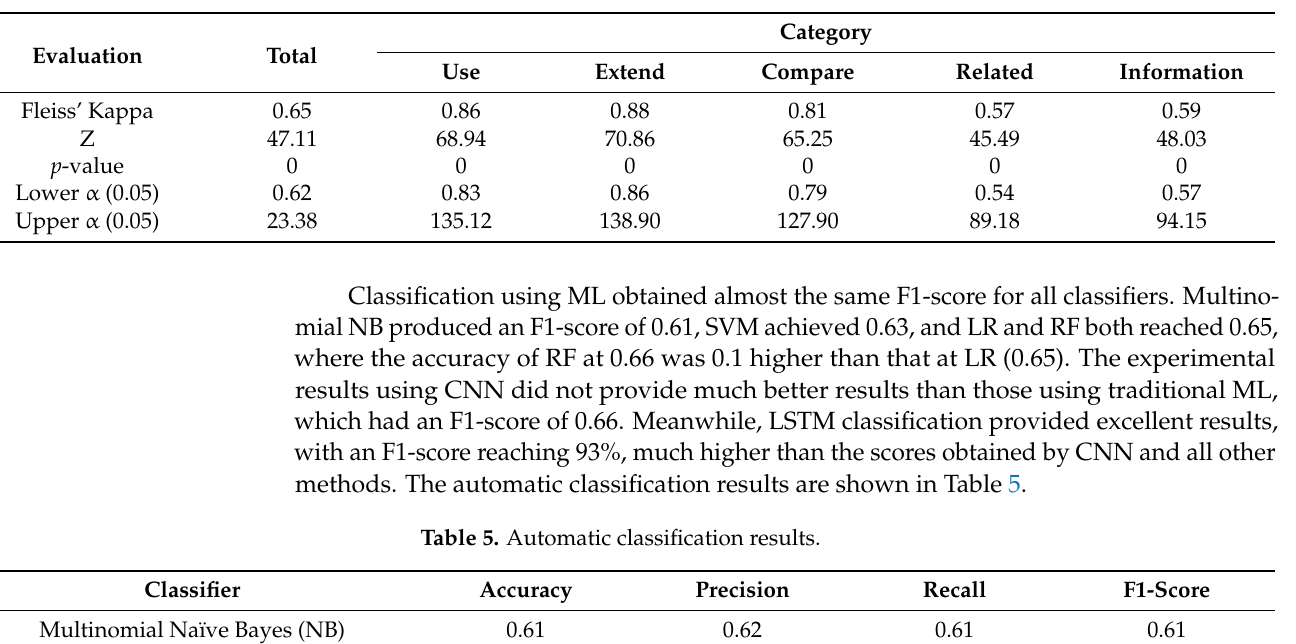
Table 4. Fleiss’ kappa values for human classification agreement.